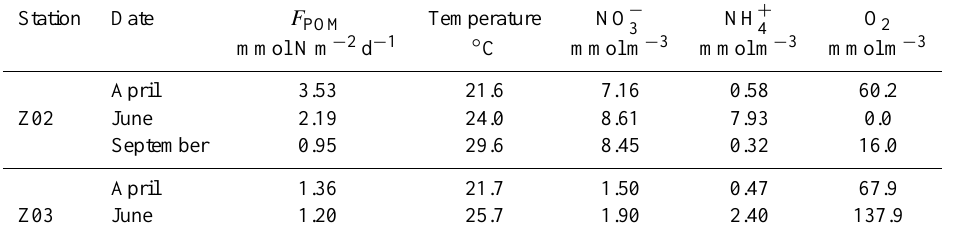
Table 1. Bottom water conditions at stations Z02 and Z03 in 2006. These data are used as forcing conditions during the optimization of the diagenetic model. POM deposition flux ( F POM ) was not measured; F POM monthly climatologies were calculated for stations Z02 and Z03 from a multiyear simulation with a biogeochemical circulation model (see Sect. 2.3).